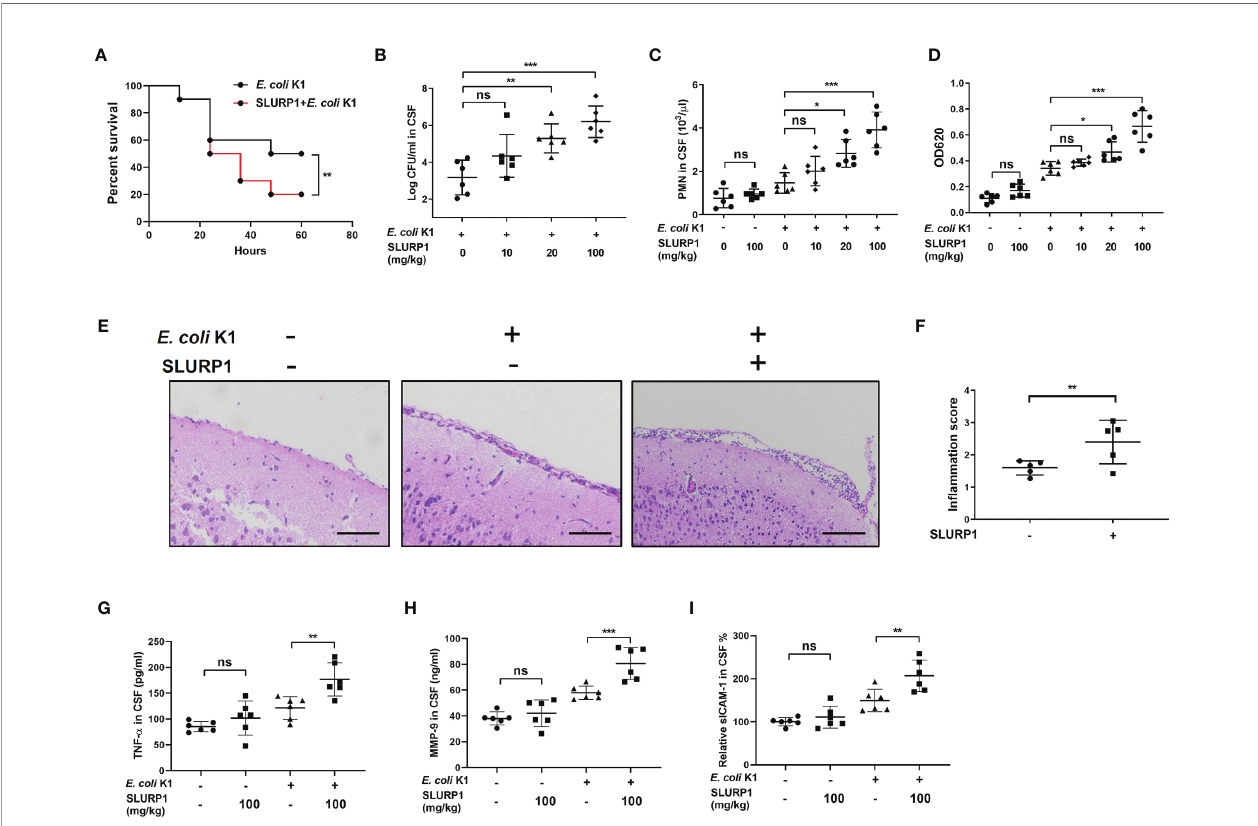
FIGURE 3 | SLURP1 promotes the pathogenesis of E coli K1 meningitis in mice model. (A) Survival curve of C57BL/6 mice treated with SLURP1 (100 mg/kg body weight) + E. coli K1 (1 × 10 6 ) or treated with only E coli K1 (1 × 10 6 ). SLURP1 was intraperitoneally injected 2 days before E coli K1 challenge. n = 10 per group. (B, C) Pathogen (B) and PMN (C) counts in the CSF of E coli K1-infected mice pretreated with BSA or indicated doses of SLURP1. (D) The OD620 values of Evans blue extracted from the brain of E coli K1-infected mice pretreated with BSA or indicated doses of SLURP1. (E) Representative H&E staining of the cortex sections, scale bar = 200 m m; and (F) meningeal in fl ammation score. (G – I) The cytokines levels in the CSF were analyzed by ELISA: TNF- a (G) , MMP-9 (H) , and ICAM-1 (I) . The H&E staining are representative of two independent experiments (E) . Data are presented as mean ± SEM from two independent experiments. Each dot indicates an individual mouse ( n = 5). * p < 0.05; ** p < 0.01; *** p < 0.001 by log-rank test (A) , Student ’ s t -test (F) , and one-way ANOVA followed by Bonferroni post-hoc test (B – D, G – I) . ns, not signi fi